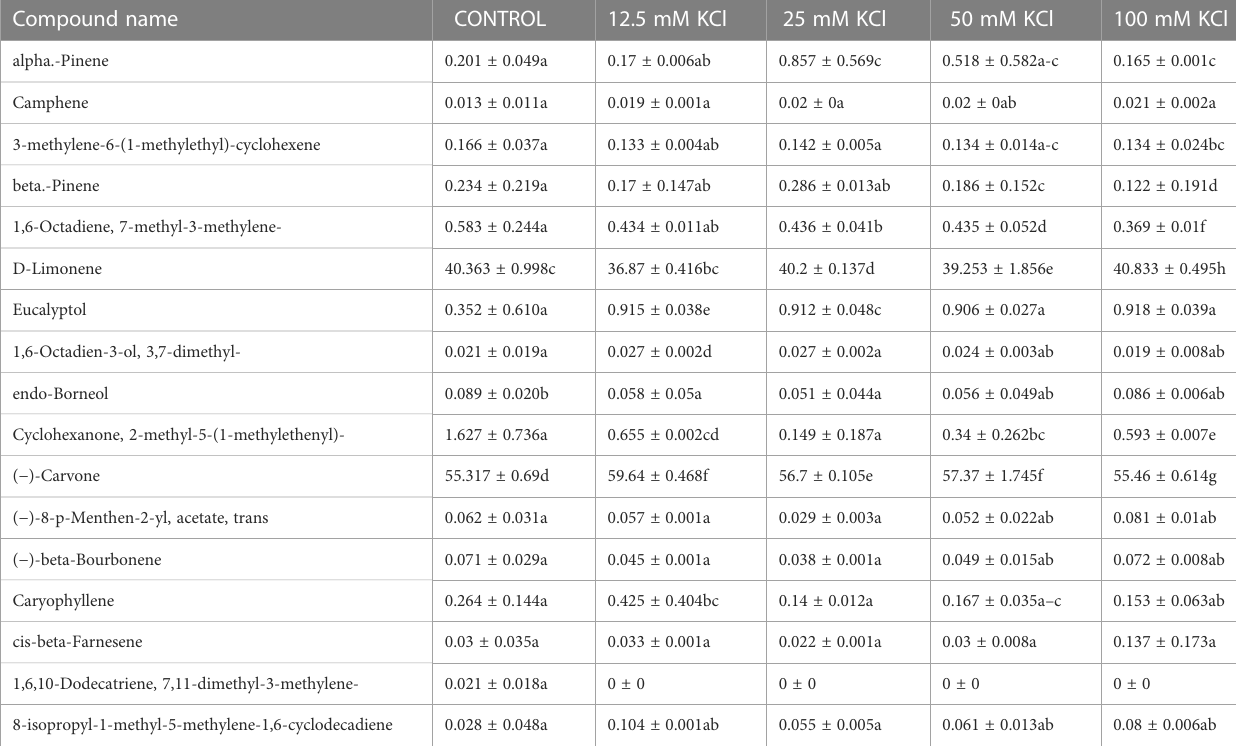
Means in the same column by the same letter are not signi fi cantly different to the test of Duncan ( a = 0.05).